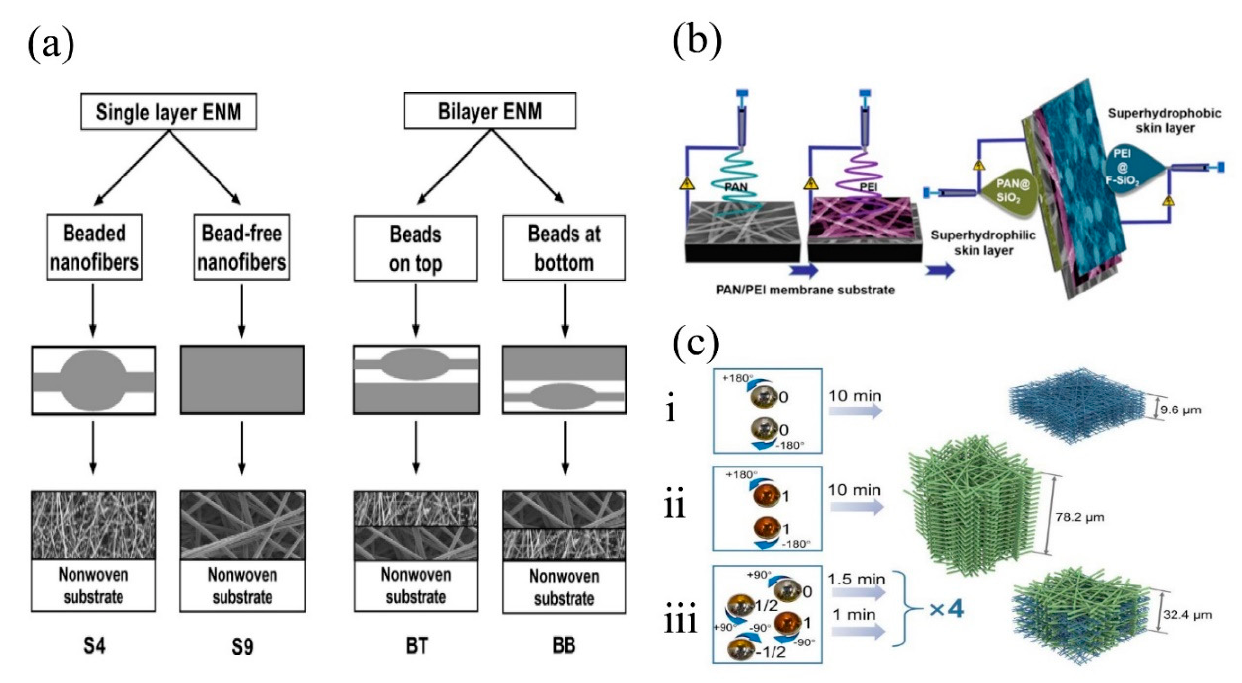
Figure 7. ( a ) Schematic representation of single and bilayer ENMs in the experimental design where S represents a single layer and B is bilayer ENM. Reprinted with permission from ref. [54]. Copyright 2019 Elsevier B.V. ( b ) Schematic illustration of the fabrication of the PAN/PEI bilayer membranes and the asymmetric superwettability skin layers. Reprinted with permission from ref. [56]. Copyright 2020 Yuyan Yang et al. ( c ) The fabrication of: ( i ). nanofibers assembled membrane (PAN- 10); ( ii ). submicron fibers assembled membrane (PAN-16); ( iii ). submicro-/nanofibers sandwich-structured membrane (PAN-10/16). Reprinted with permission from ref. [59]. Copyright 2018 IOP Publishing